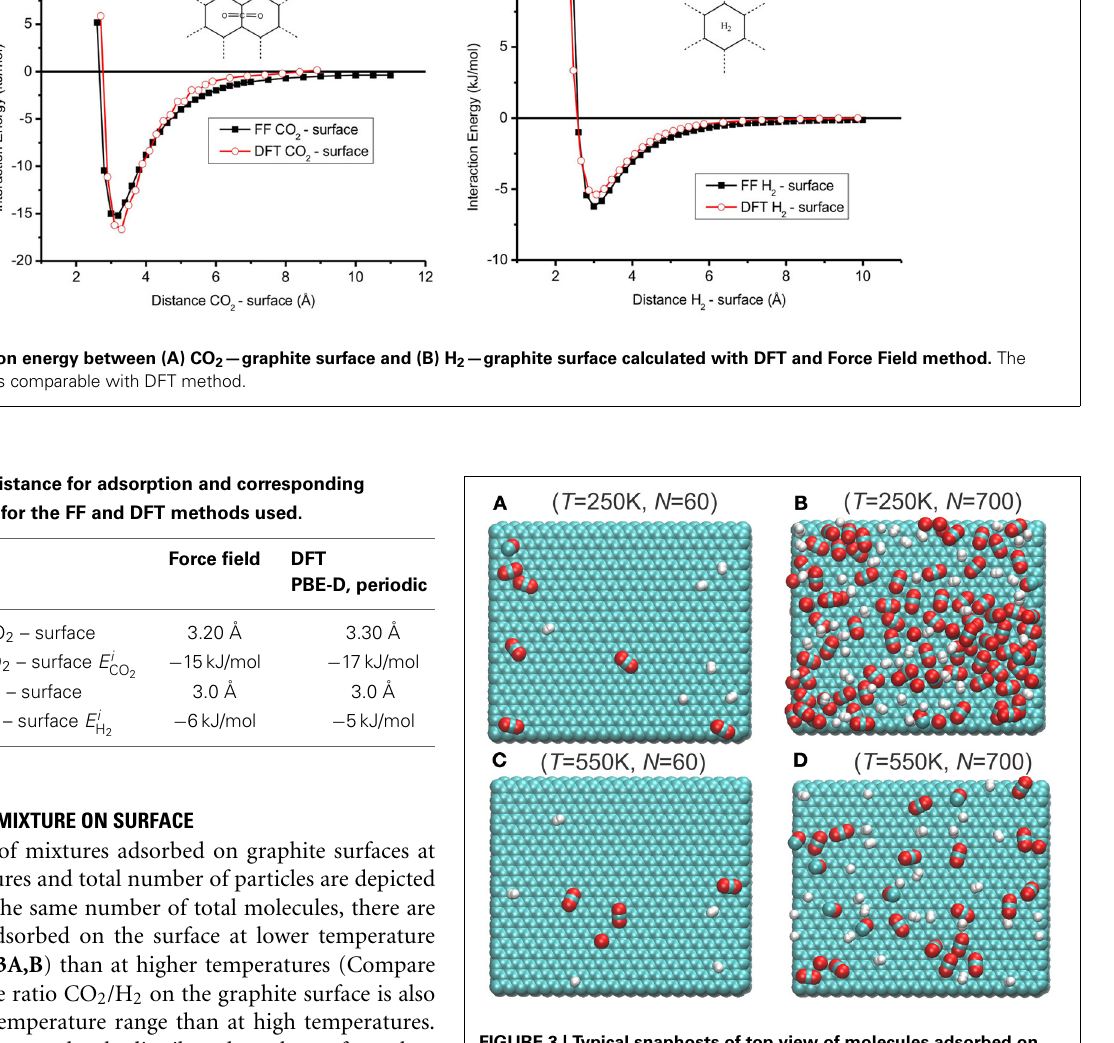
( Figure 4 ). The Heaviside function, θ , is by definition unity,